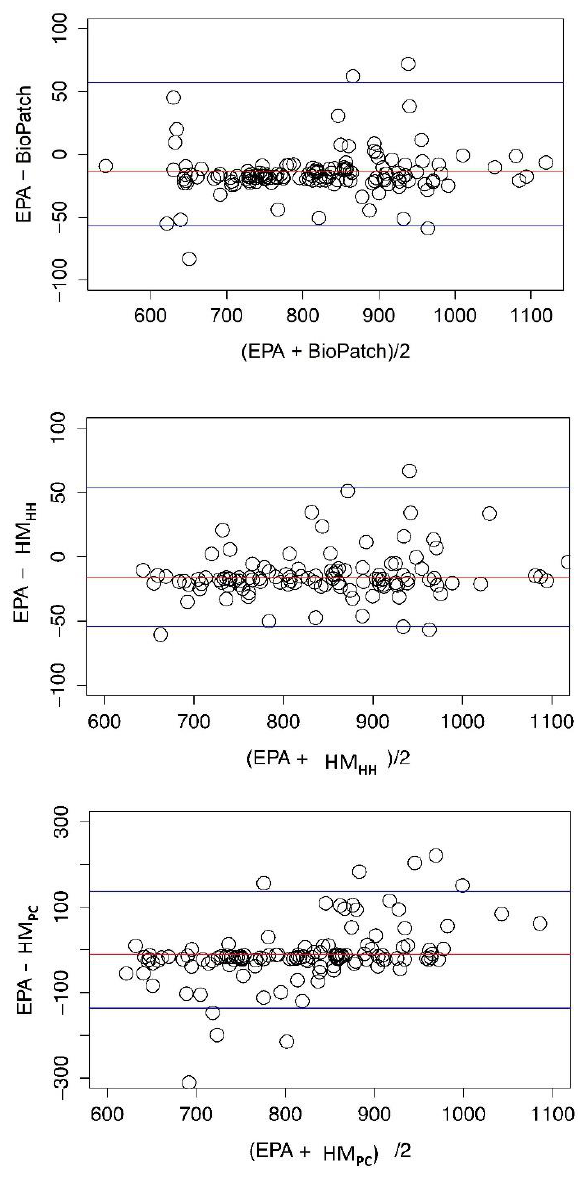
Figure 2. Inter-device agreement EPA6 and three portable devices . Agreement between the EPA6 and three portable devices using the Bland–Altman method is depicted (Bland and Altman, 1986). For any given measure and condition the average value obtained in the two methods is plotted on the x-axis and the difference is plotted on the y-axis. Data from all five behavioral conditions are shown in the diagram. Top: Comparison of the EPA6 and the BioPatch. Middle: Comparison of the EPA6 and the HeartMath handheld device. Bottom: Comparison of the EPA6 and the HeartMath device connect to a PC. Note that the specification of the y axis in this panel differs from that in the two preceding panels.